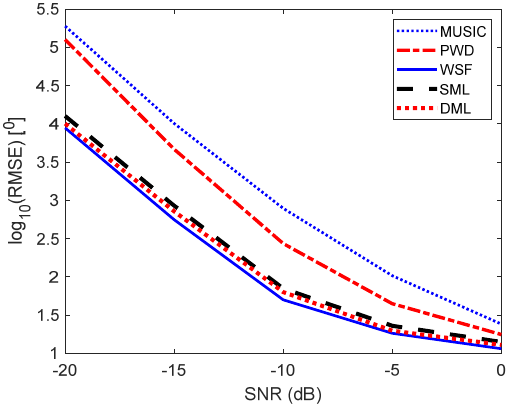
Figure 6. RMSE versus SNR comparison test between MUSIC, PWD, DML, SML, and WSF.